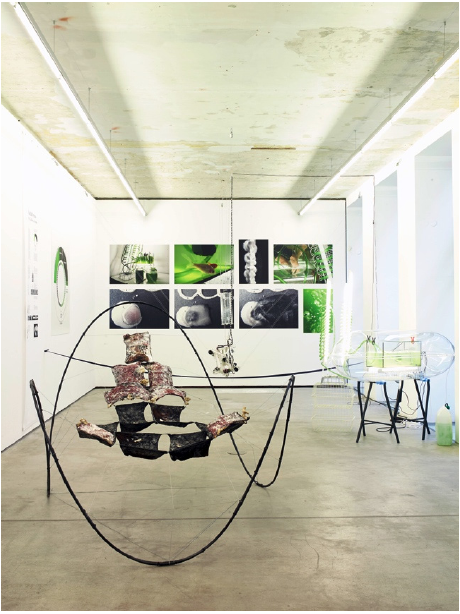
Figure 21. Exhibition October 2015, with mycelium material grown in textile shapes in the foreground and an algae bioreactor and cable printer in the background. © Bruno Stubenrauch. and an algae bioreactor and cable printer in the background. © Bruno